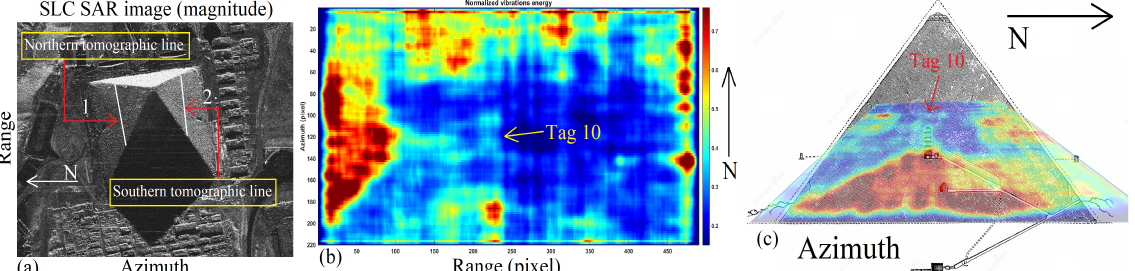
Figure 48. SLC SAR image (magnitude). ( a ): SAR image in magnitude. ( b ): Tomographic result (Top-side view). ( c ): Tomographic result (East-side